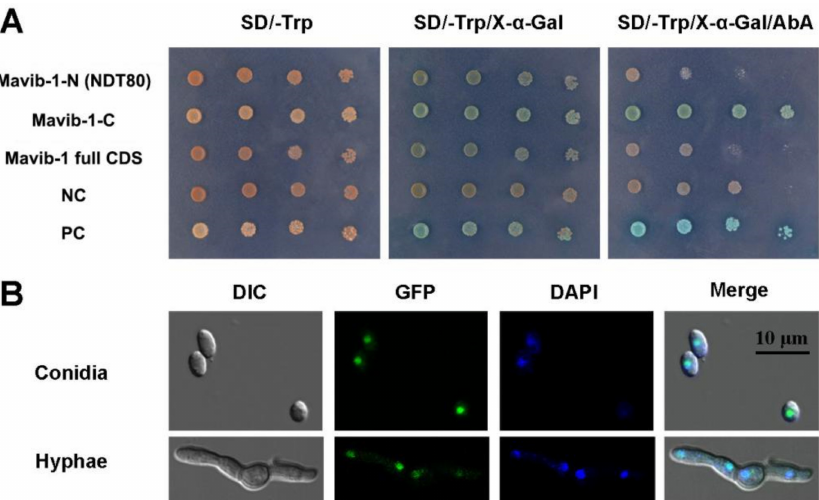
Figure 1. Transcriptional-activation assays and subcellular localization of Mavib-1. ( A ) Transcriptional activation assays in yeast. Mavib-1-N (containing NDT80 domain), Mavib-1-C or Mavib-1 full CDS were fused to the GAL4 DNA-binding domain and expressed in yeast strain Y2H Gold. Strain containing only GAL4 DNA-binding domain was as negative control (NC), containing the GAL4 DNA-binding and activation domains were as positive controls (PC). All the yeast strains were cultured on SD-Trp plates, SD-Trp plates containing 0.5 mM X- α -gal and SD-Trp plates containing 0.5 mM X- α -gal and 200